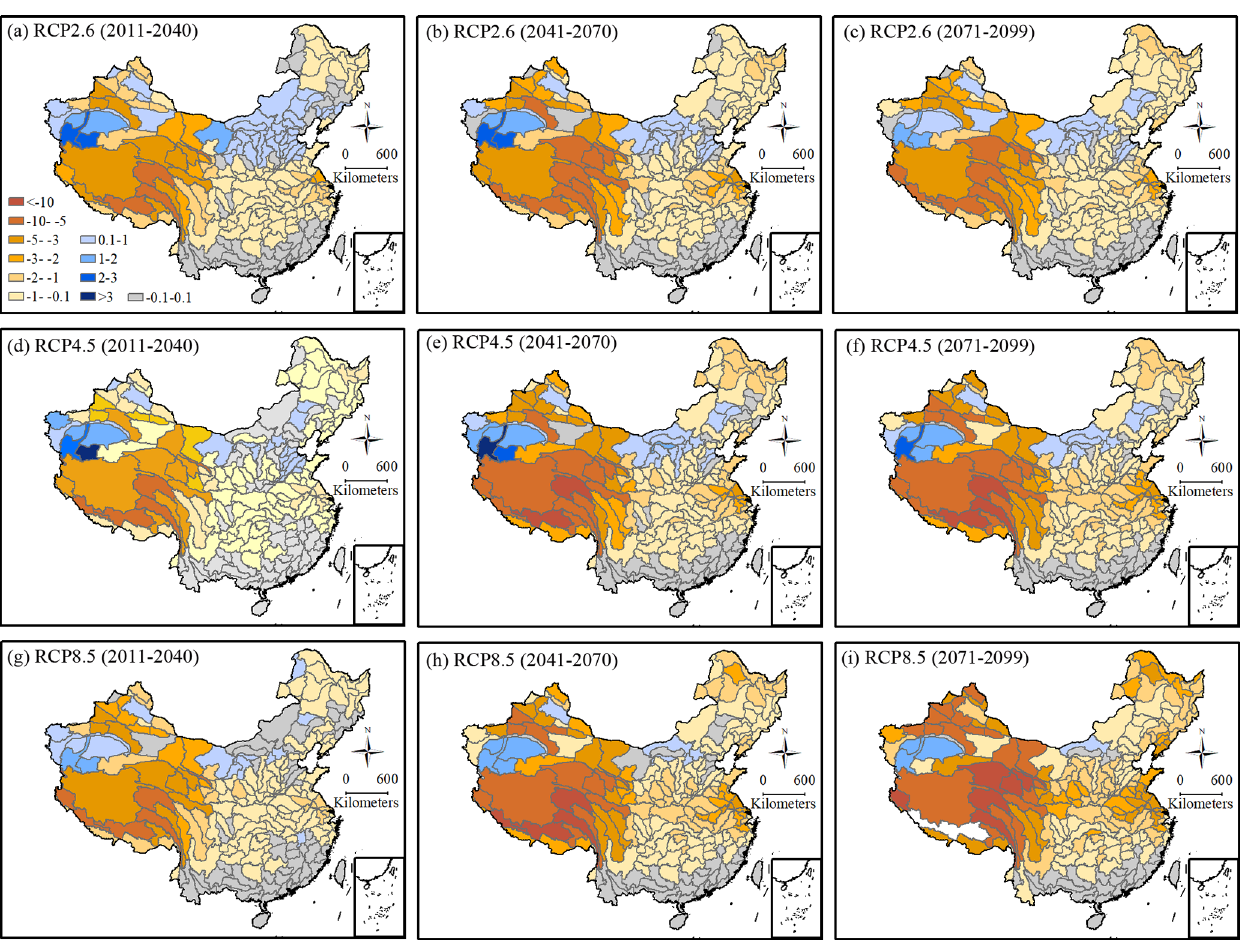
Figure 14. Spatial distributions of differences (percent) between the projected mean annual snowmelt runoff ratio and the reference period (1981–2010) for the near future (2011–2040), mid-future (2041–2070) and far future (2071–2099) under RCP2.6, RCP4.5 and RCP8.5 in